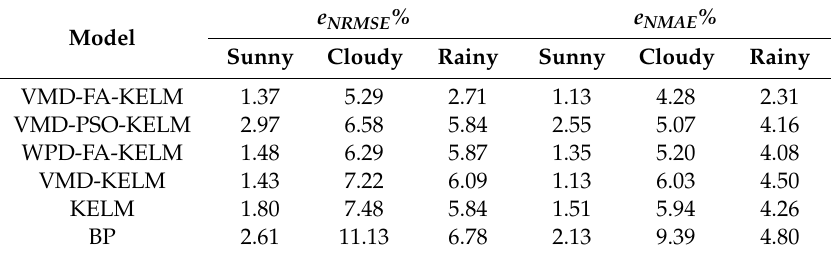
Table 6. Point prediction indices of di ff erent optimization algorithms.